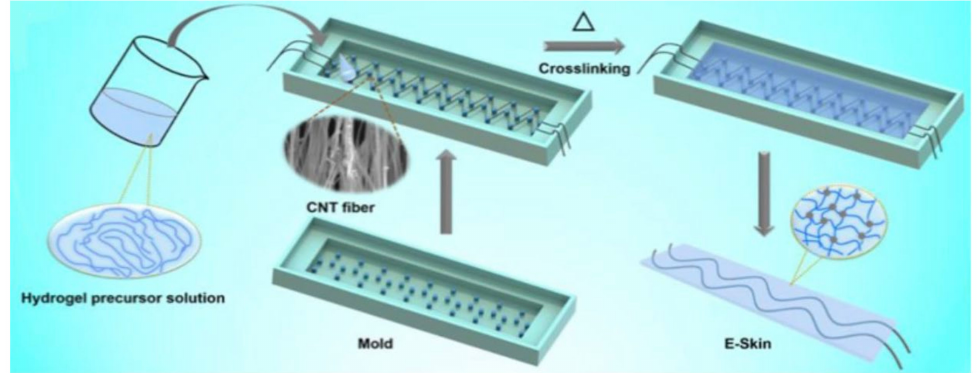
Figure 20. Schematic diagram of the CNT fiber/PAAM hydrogel (CFPH) composite preparation process. Reprinted with permission from